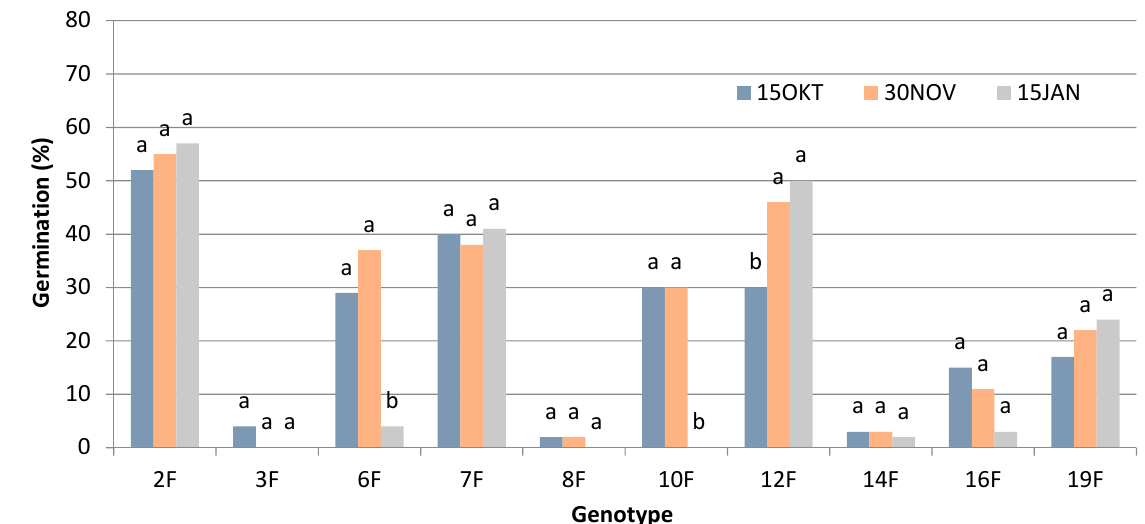
Figure 5. Effect of different time-periods of seed harvesting (15 October, 30 November or 15 January) on germination of ten female genotypes of P. lentiscus var. Chia, three weeks from the day of sowing. Different letters in each genotype indicate statistically significant differences according to Duncan’s multiple range test at p ≤ 0.05.